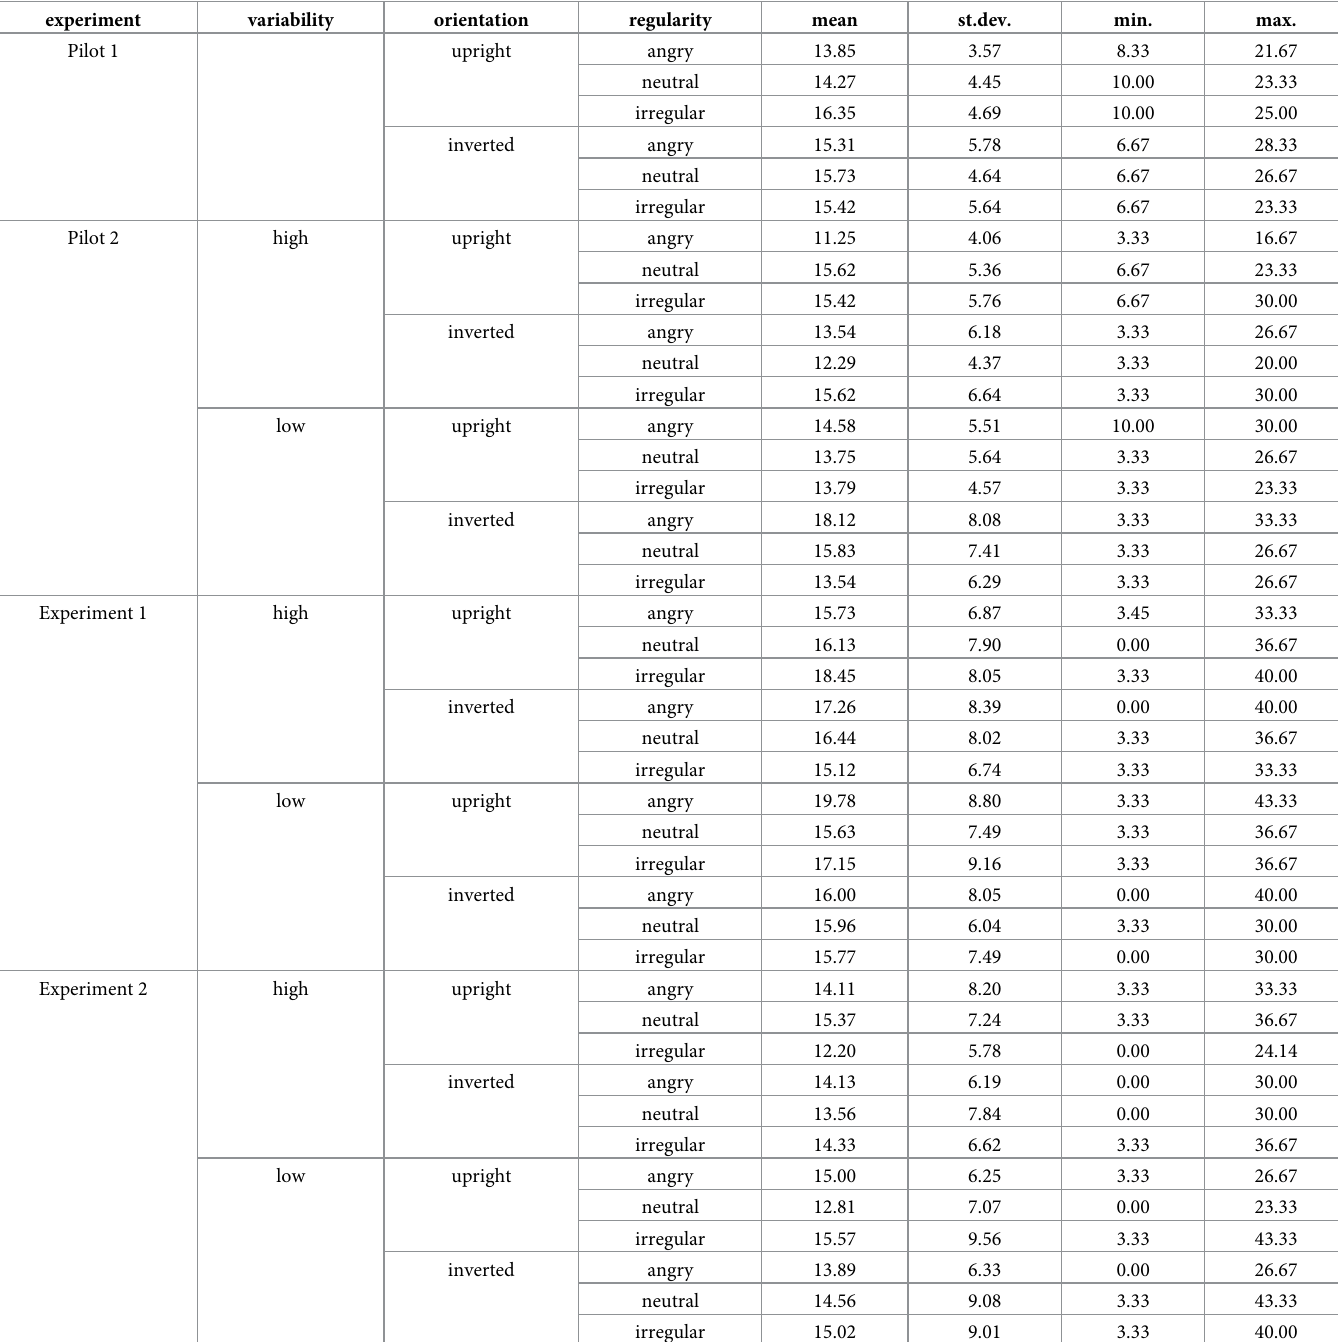
Table 1. Percentage of rejected epochs after